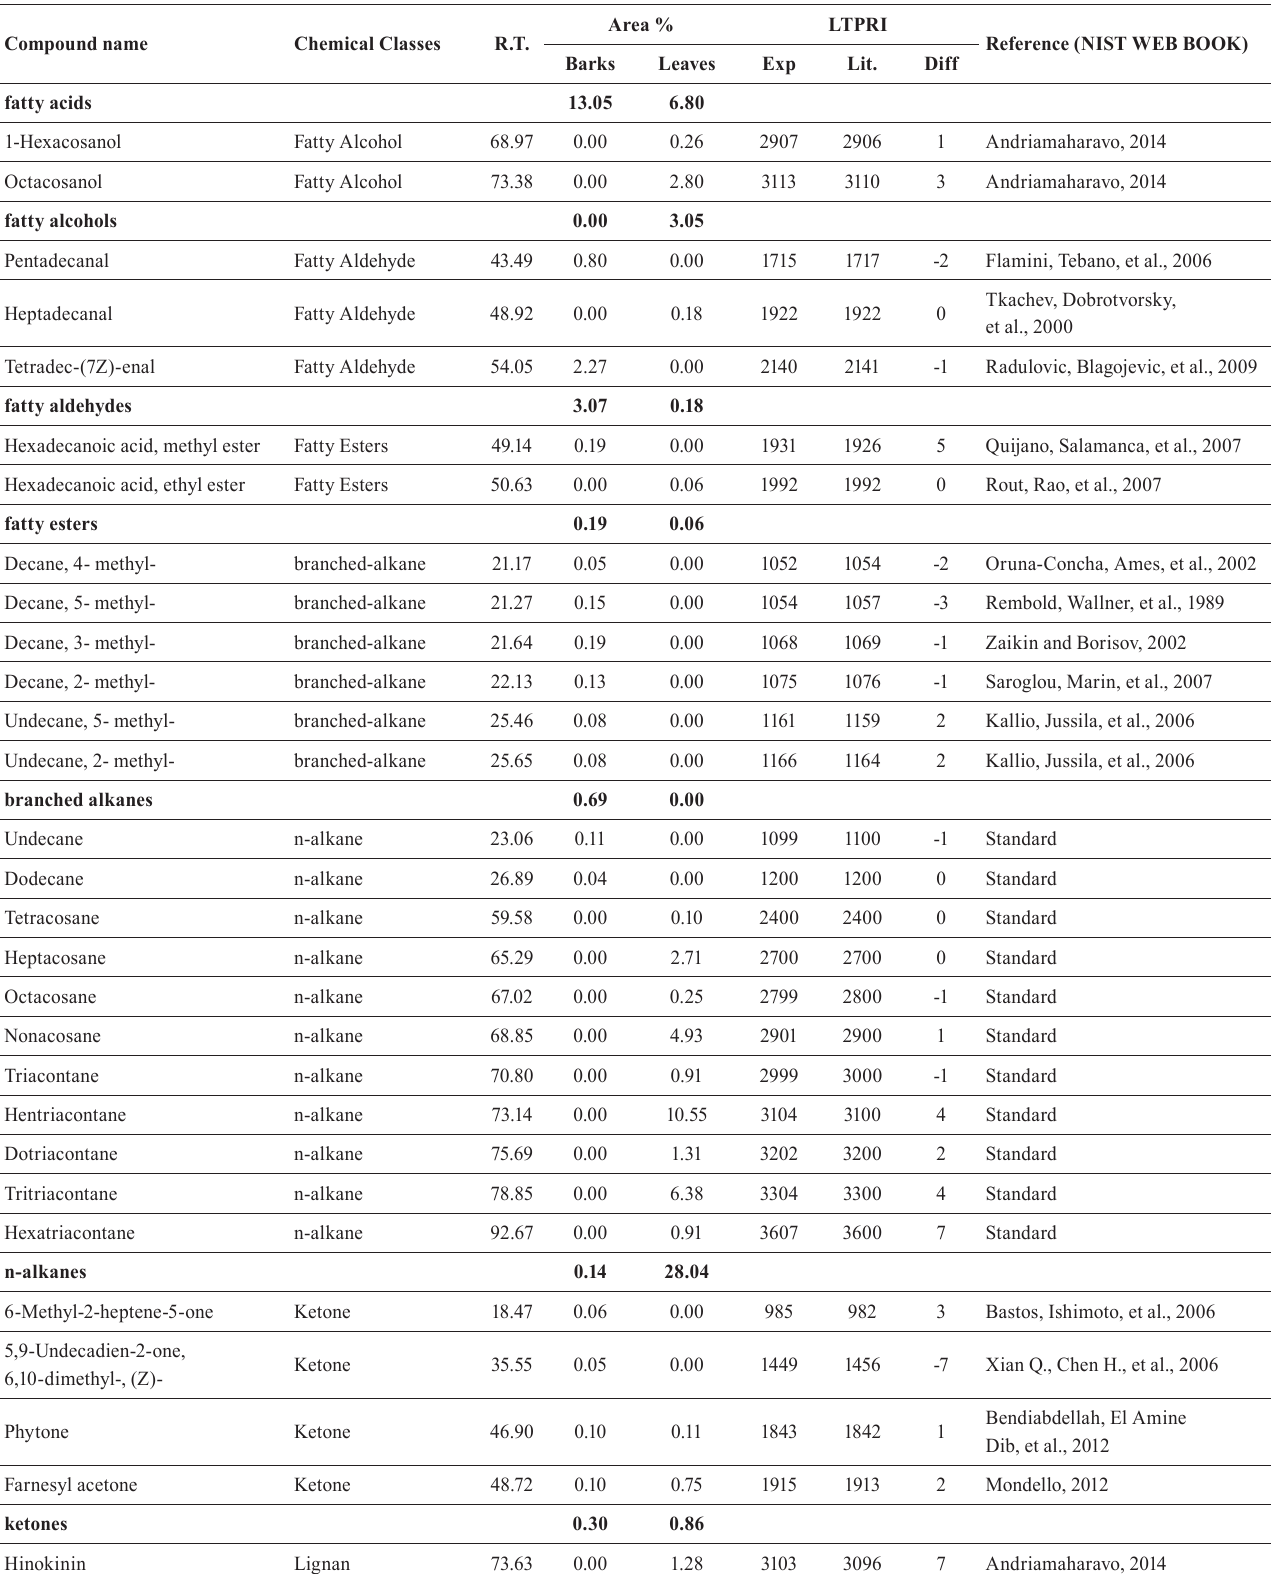
TABLE SI - Tentatively identified compounds in Essential Oils from barks and leaves of Commiphora Leptophloeos by